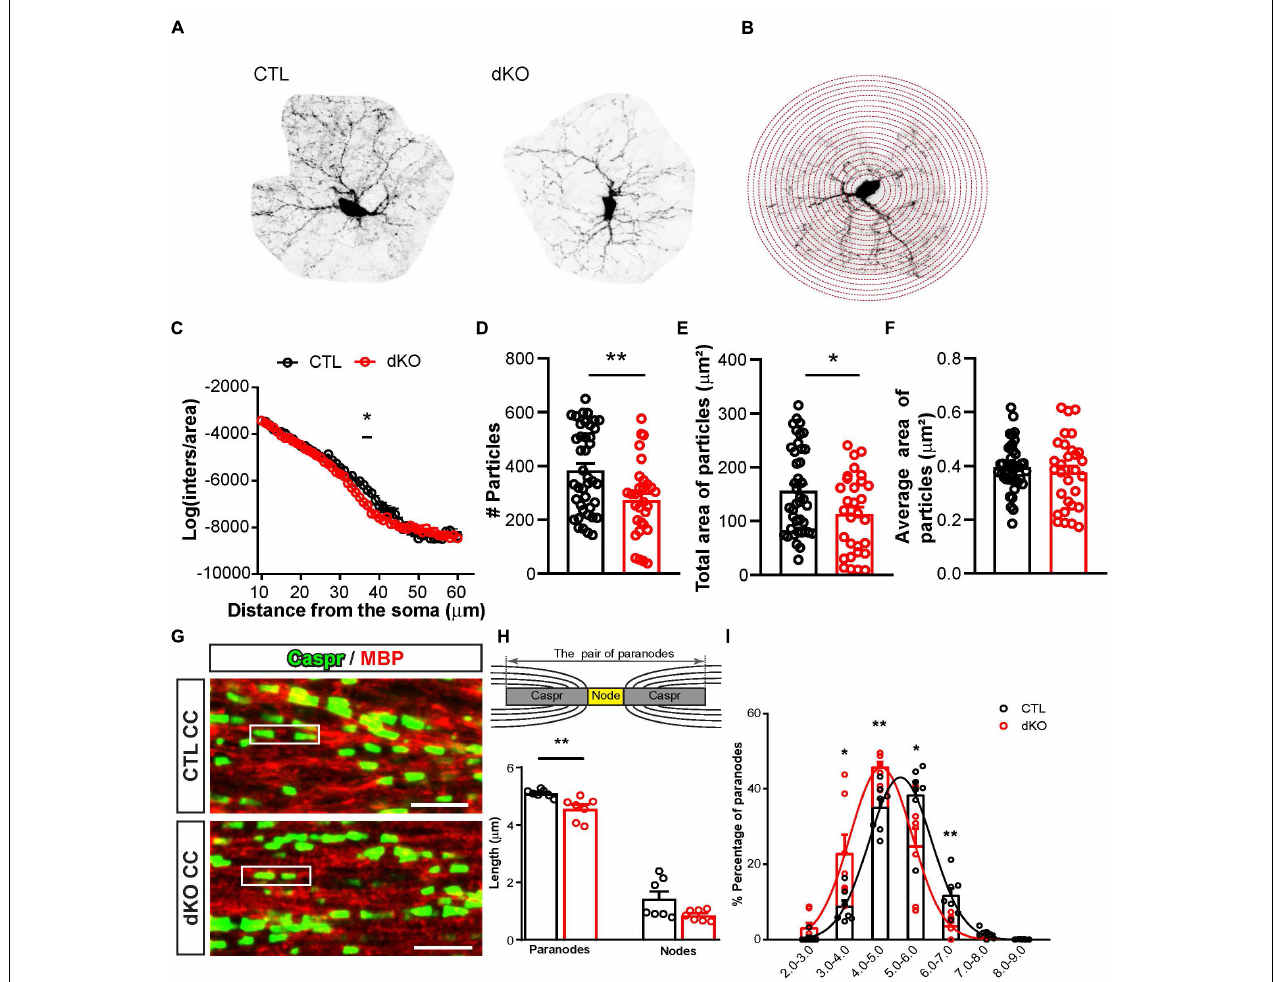
FIGURE 3 | Conditional gene ablation of Cav1.2 and Cav1.3 resulted in a less complex morphology of NG2 glia and shortened paired paranodes. (A) A typical NG2 glia cell in layer II/III of cortex from CTL and dKO mice. (B) Sholl analysis with process intersections being counted every 1 µ m. (C) In the range of 32–41 mm, i.e., far away from the soma, Cav1.2/1.3 deficient NG2 glia displayed less processes than controls. (D–F) The processes quantification using binary threshold analysis shows that Cav1.2/1.3 deficient NG2 glia had less particle-shaped varicosities (D) , which occupied a smaller total area (E) than control NG2 glia, while the average particle size was unaltered (F) . Each datapoint represents data from a single NG2 glial cell. (G) Co-immunolabeling of CASPR (green) and MBP (red) in the CC. Scale bar = 5 µ m. (H) The paired paranodes in mutant mice were shorter than controls. Each datapoint represents data obtained from a single mouse. The upper depicts the quantification of paired paranodes. (I) The distribution of paired paranodes in dKO mice showed a left shift compared to controls. * p < 0.05; ** p <